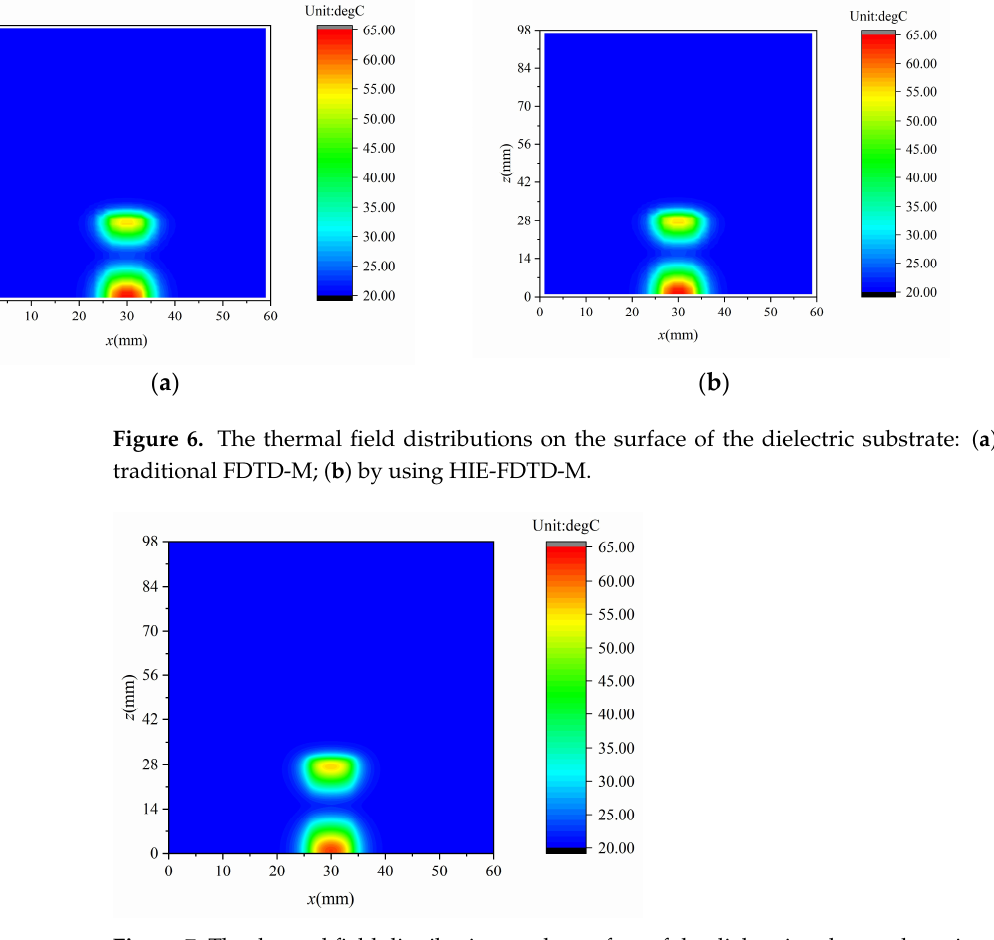
Figure 7. The thermal field distribution on the surface of the dielectric substrate by using COMSOL.